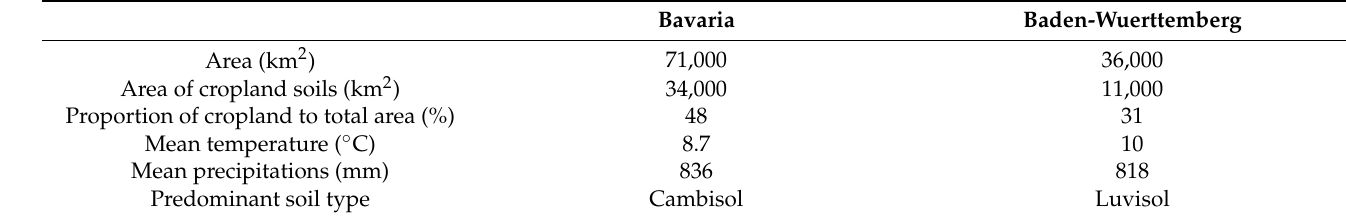
Figure 1. Study area: ( A ) Sampling locations in Bavaria (east) and Baden-Wuerttemberg (west). (LUCAS = The Land Use and Cover Area Frame Survey, LfU = Bavarian Environment Agency, LGRB = State Authority for Geology, Resources and Mining; ( B ) Location within Germany; ( C ) Mask of the exposed soils (black) in the soil reflectance composite. Table 1. Comparison of both federal